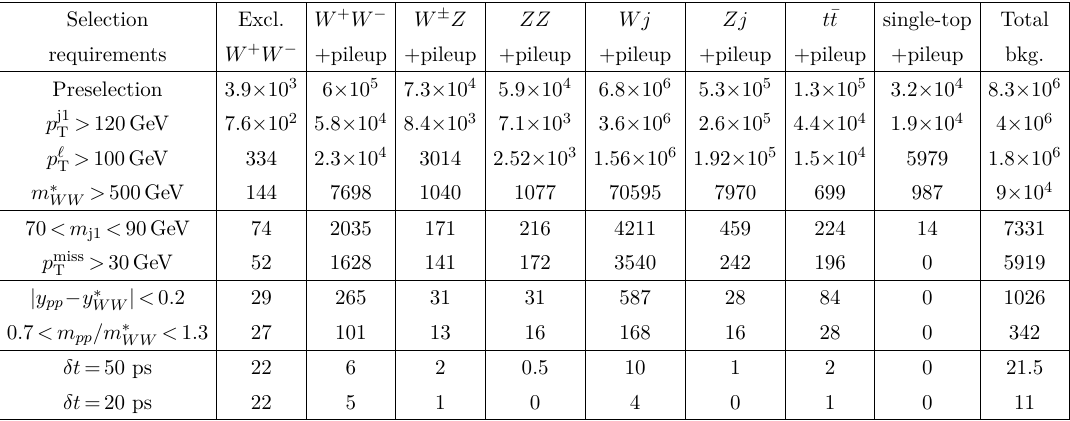
Table 2 . Number of events for 300 fb − 1 after each selection criterion for W + W − exclusive signal (when one W boson decays leptonically and the other one into hadrons), non-diffractive W + W − + pileup, W ± Z + pileup, ZZ + pileup, W ± + jet +pileup, t ¯ t +pileup, single-top+pileup backgrounds. The bottom two rows correspond to the options of time-of-flight difference measurement of the scattered protons with precision of 50 ps or 20